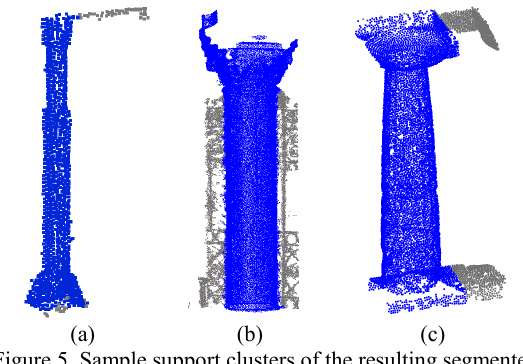
Figure 5. Sample support clusters of the resulting segmented point cloud from each data set: (a) Kasepuhan, (b) St-Pierre, and (c) Paestum. Blue colour denotes true positive points, while grey ones are false positive